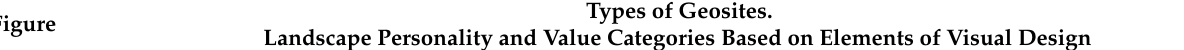
Types of Geosites.